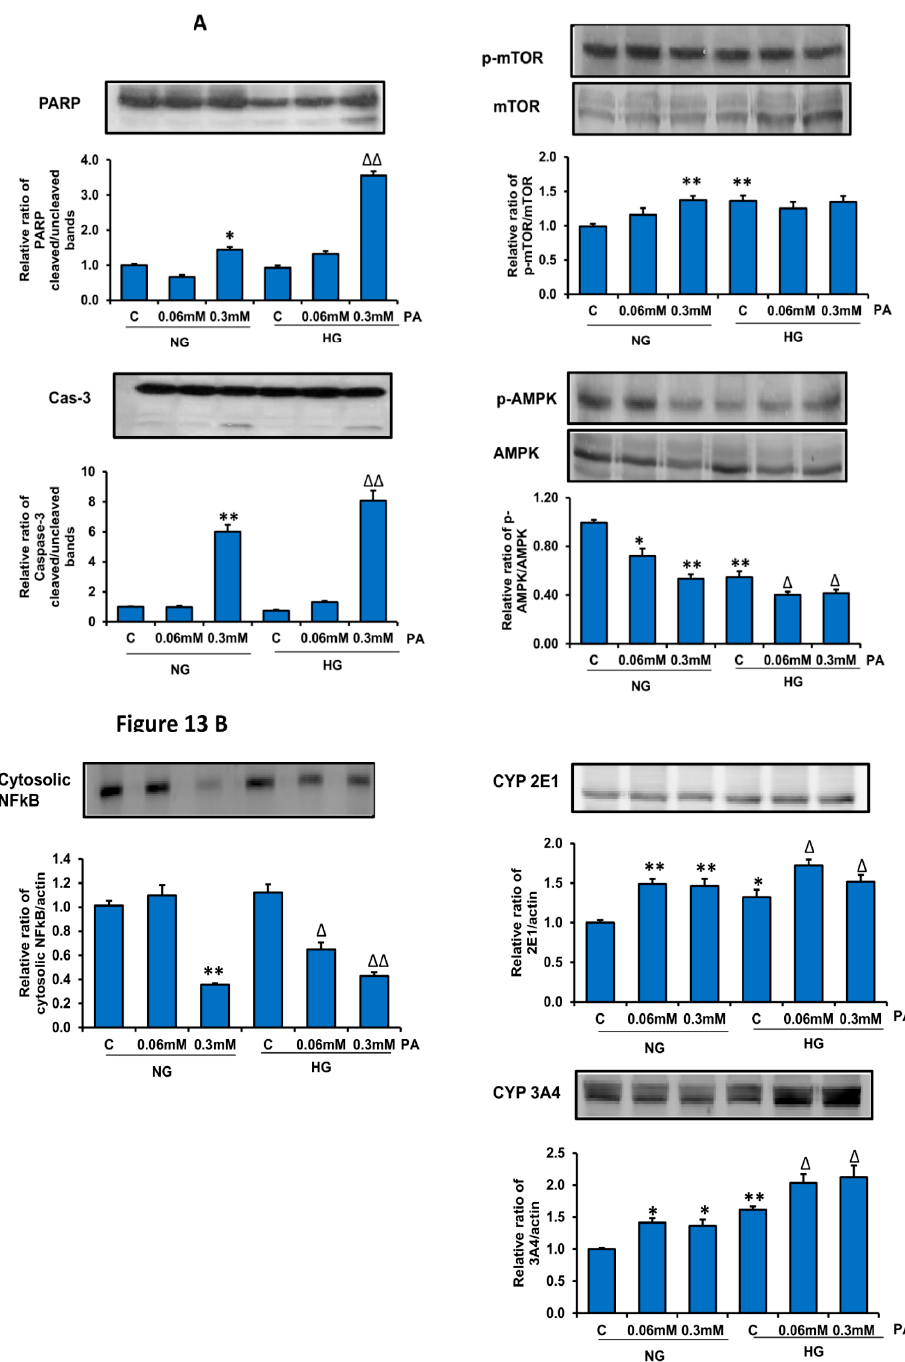
Figure 13. Effect of HG/HPA on protein expression. Samples of 50 ug protein from control and HG/HPA treated cellular extracts were separated on 12% SDS-PAGE gels and electroblotted onto nitrocellulose by western blot technique. The proteins were then detected using specific antibodies for PARP, caspase-3, mTOR, p-mTOR, AMPK, p-AMPK ( A ), and NFkB, CYP 2E1, and CYP 3A4 ( B ). Beta-actin was used as loading control. The quantitation of the protein bands is expressed as relative ratios normalized against actin or other specific proteins as appropriate. The figures are representative of three experiments. Asterisks indicate significant difference (* p ≤ 0.05, ** p ≤ 0.005) relative to untreated control cells under normal glucose condition (NG-C), ( Δ p ≤ 0.05, ΔΔ p ≤ 0.005) relative to untreated control cells under high glucose condition